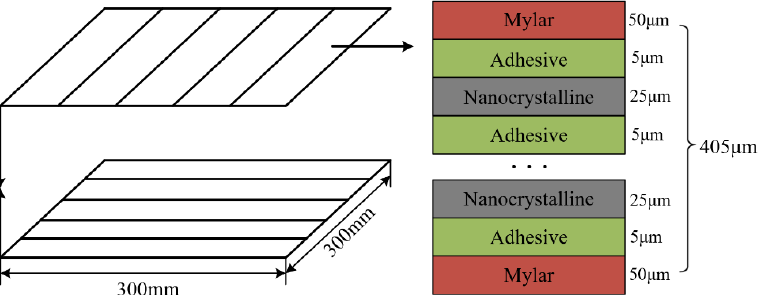
Figure 2. Nanocrystalline staggered lamination splicing